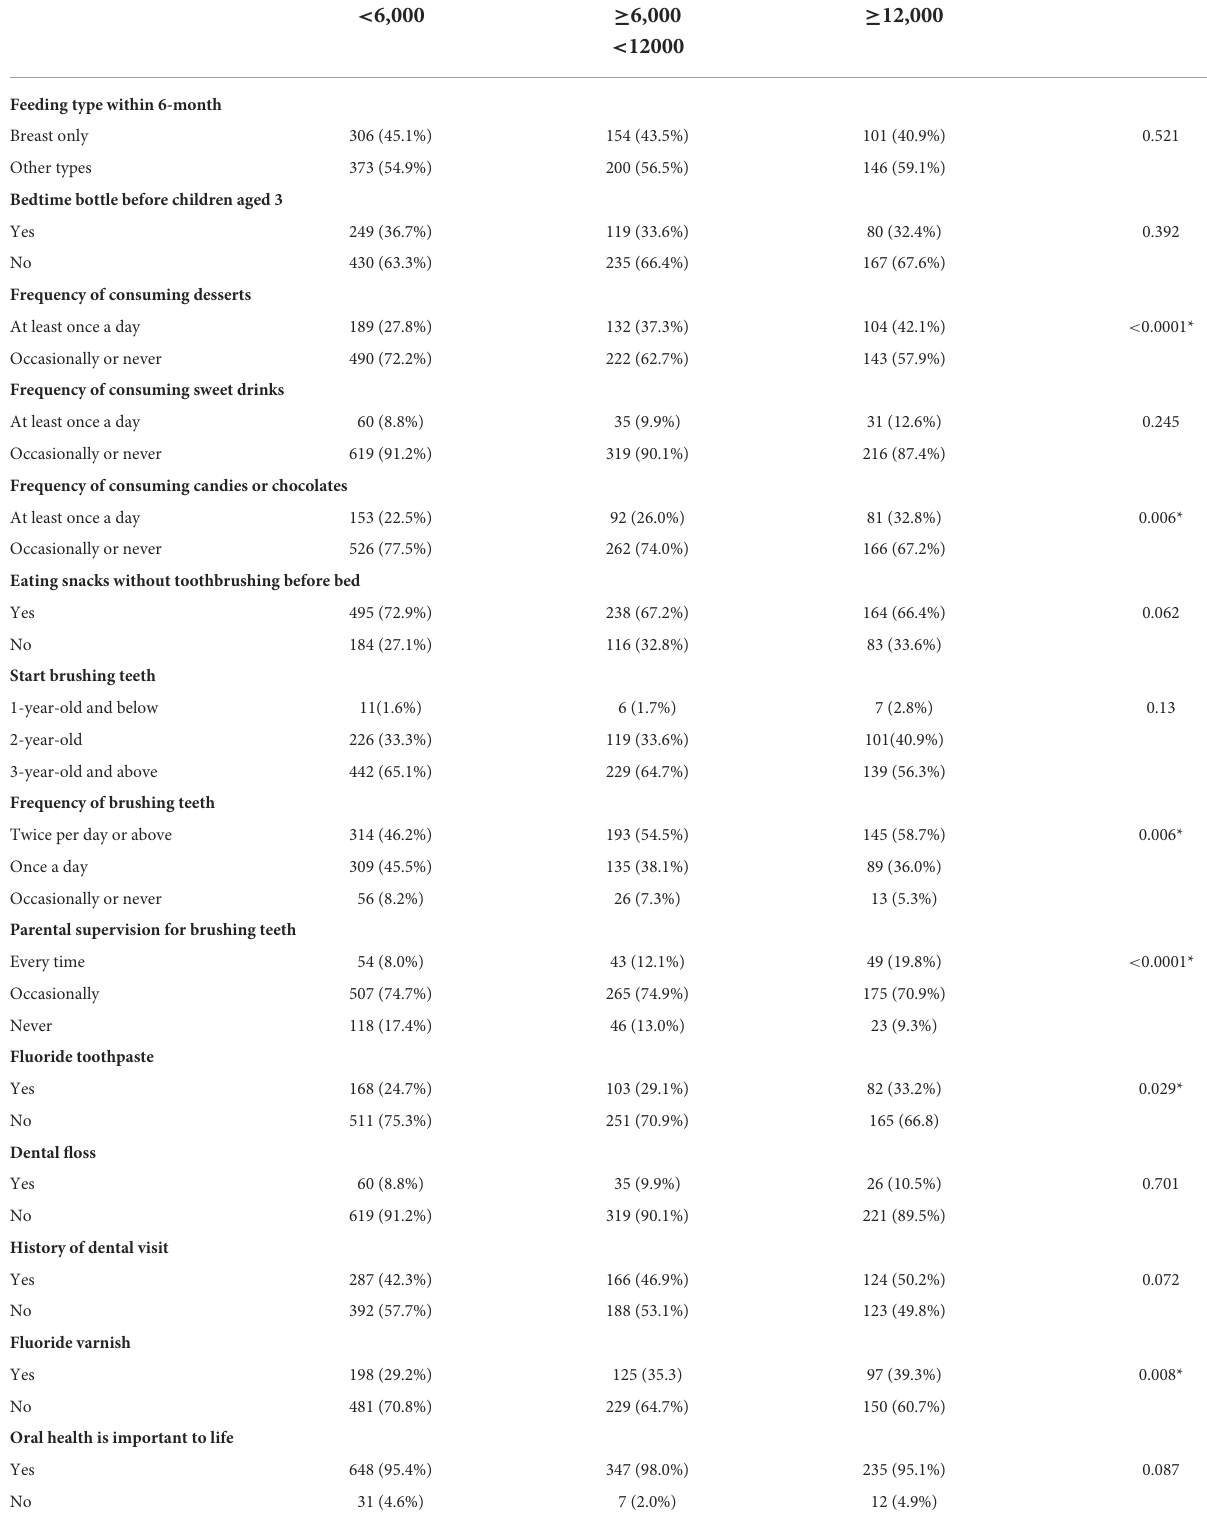
TABLE 6 Family income and different variables ( N =